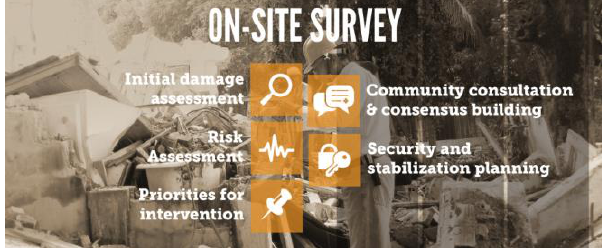
Figure 6. On-site survey was stressed at other points in the course (ICCROM,